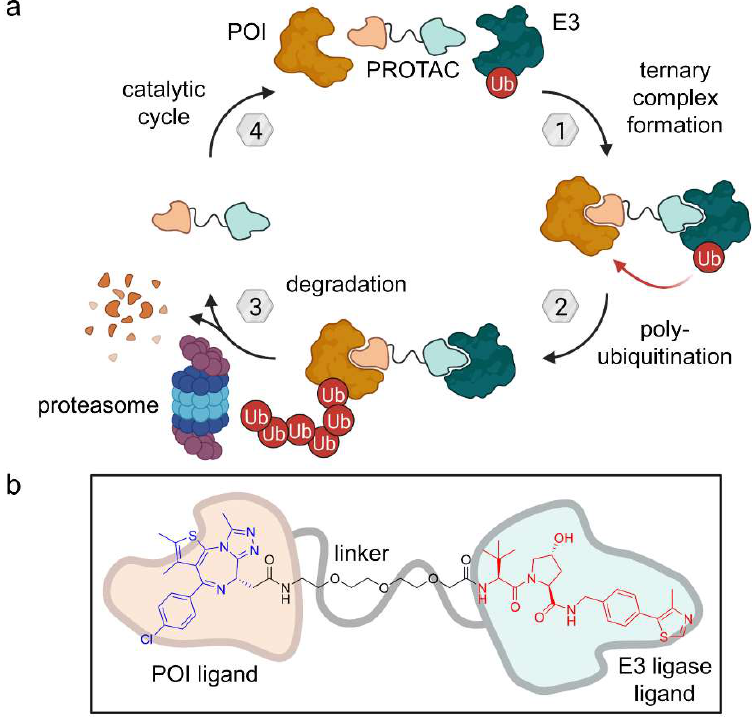
Figure 4. ( a ) Proteolysis-targeting chimeras (PROTACs) are heterobifunctional molecules which bind to the protein of interest (POI) as well as an E3 ligase leading to polyubiquitination and subsequent proteasomal degradation. Provided that the PROTAC bond is reversible, they act as a catalyst. ( b ) Exemplary PROTAC targeting BRD4 as POI and VHL as an E3 ligase [16].